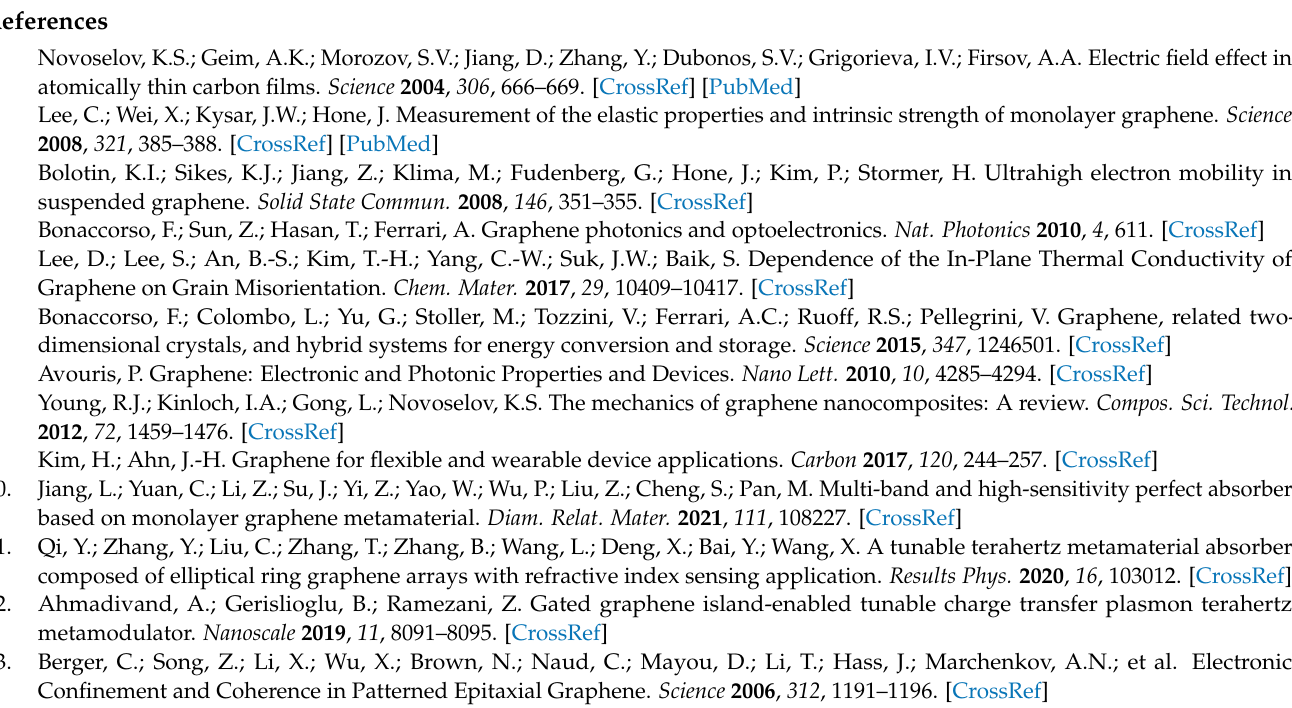
Figure S2: Photograph of (a) graphite foils and (b) dispersed EEG flakes in DMF; Figure S3: Schematic illustration of the mode I fracture tests of the EEG paper; Figure S4: TGA curve of the EEG paper; Figure S5: SEM images of the fracture surfaces of the upper and lower Si strips after the fracture tests; Figure S6: Raman spectra of the EEG paper after fracture; Figure S7: Raman intensity maps of the D band and G band for the fracture